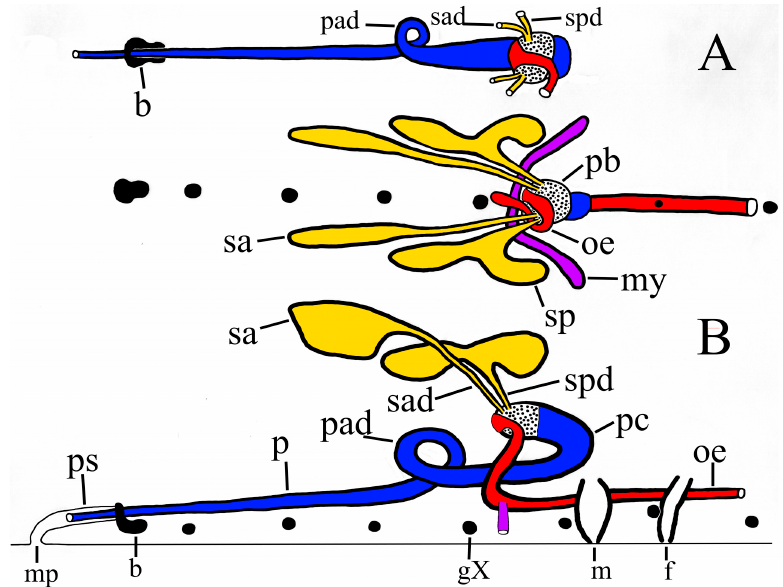
Figure 7. Scheme of the proboscis complex of P. parasitica , based on dissection of a mature specimen (PP-4a, 39.8 mm) from Tyrrell County, NC. ( A ) Dorsal view, with proboscis inset separately for clarity. ( B ) Lateral view. Note particularly the loop of the proboscis in segment IX (pad). Abbreviations: b, brain; f, female gonopore; gX, ganglion X; m, male gonopore; mp, mouth pore; my, mycetome; oe, oesophagus; p, proboscis; pad, asymmetrical deflection of proboscis at segment IX; pb, base of proboscis; pc, proboscis crook; ps, proboscis sheath; sa, anterior salivary gland; sad ductule of anterior salivary gland; sp, posterior salivary gland (bilobed); spd, ductule of posterior salivary gland.